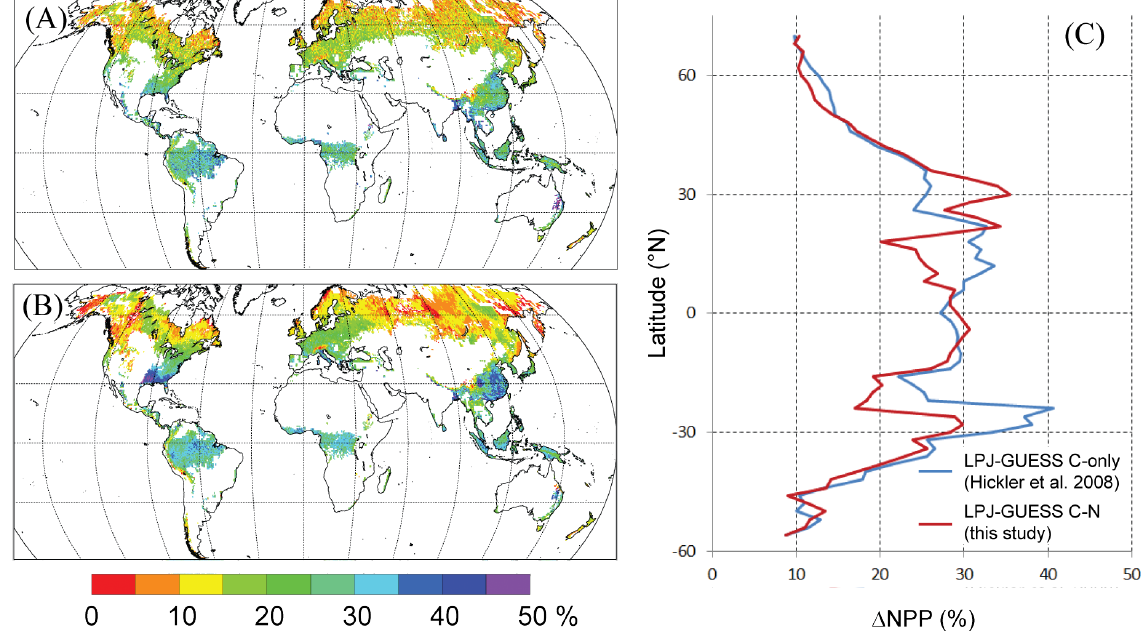
Fig. 6. Geographic pattern of simulated NPP enhancement (%) (1996–2002) resulting from a step increase of atmospheric CO 2 concentration from ambient to 550ppmv; (A) pattern of NPP enhancement from C-only model in Hickler et al. (2008); (B) corresponding pattern from LPJ-GUESS C–N (present study); (C) average NPP enhancement by latitude band from Hickler et al. (2008) and present study.